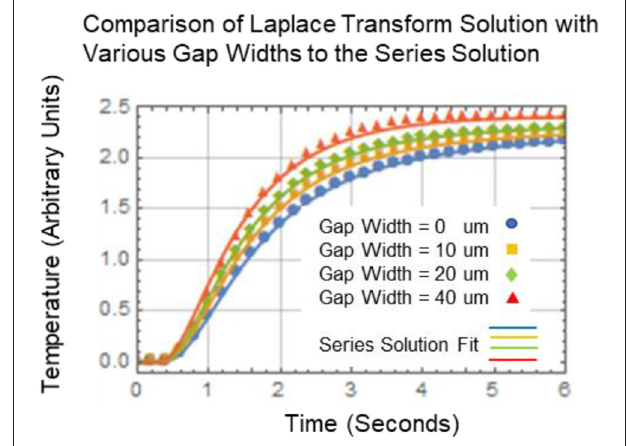
FIGURE 9 | Comparison between the series solution of Equation (1) and the numerically inverted results of Equation (2) for various air gap spacing.